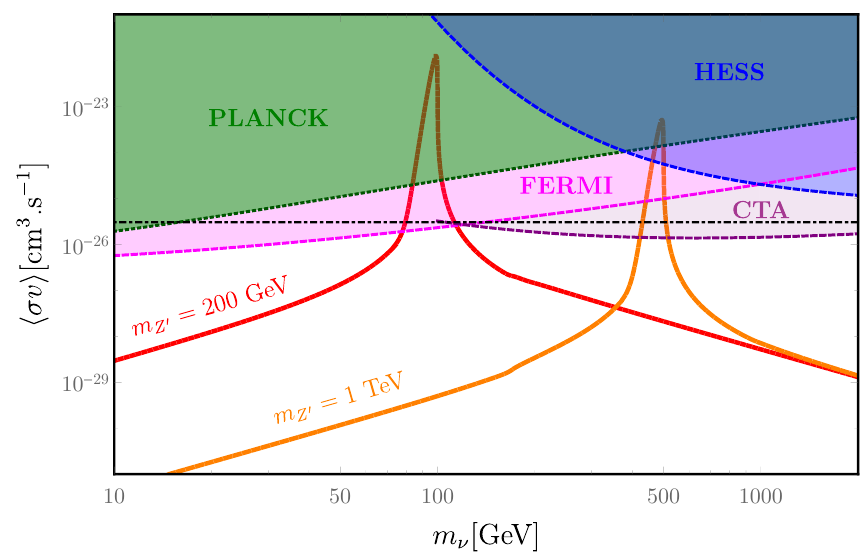
Figure 4 . Dark matter velocity averaged annihilation cross section for M Z 0 = 200(1000) GeV in red (orange) assuming g bb = g (cid:23)(cid:23) = g (cid:22)(cid:22) = 0 : 1 and indirect detection limits assuming (cid:22) bb as (cid:12)nal state from HESS [79] in blue, Fermi [80] in pink and predictions for the upcoming CTA [81] assuming 500h of observation toward the Galactic Center in purple. Limits from the Planck collaboration [82] are shown in green, assuming dark matter annihilation to (cid:22) (cid:22)(cid:22) . The dotted-dashed black line represents the canonical value of the cross section h (cid:27)v i = 3 (cid:2) 10 (cid:0) 26 cm 3 s (cid:0) 1